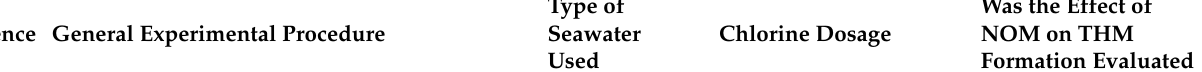
Table 1. Experimental procedures in previous studies that evaluated the effect of SWI on THM formation in comparison with the current